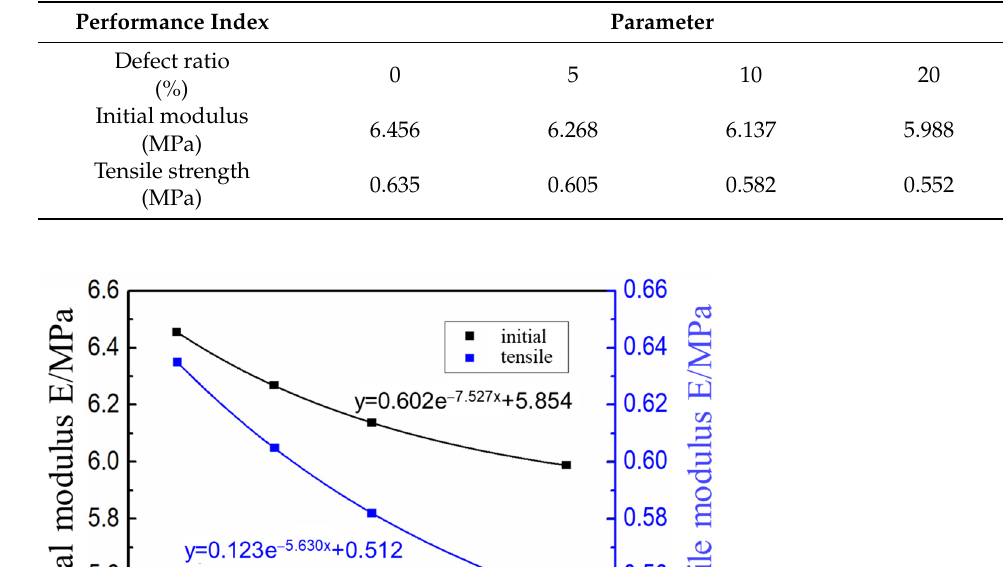
Table 6. Mechanical property parameters of HTPB propellant containing interface defects.